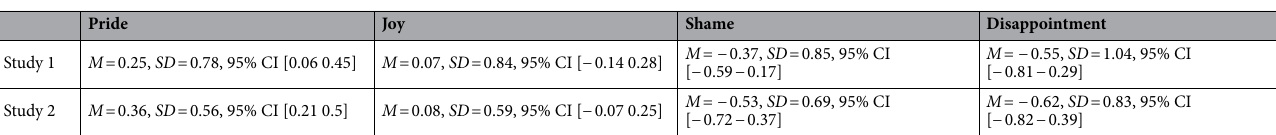
Table 1. A summary of the average changes in upper-body posture elevation for each the four emotions in each of the studies.